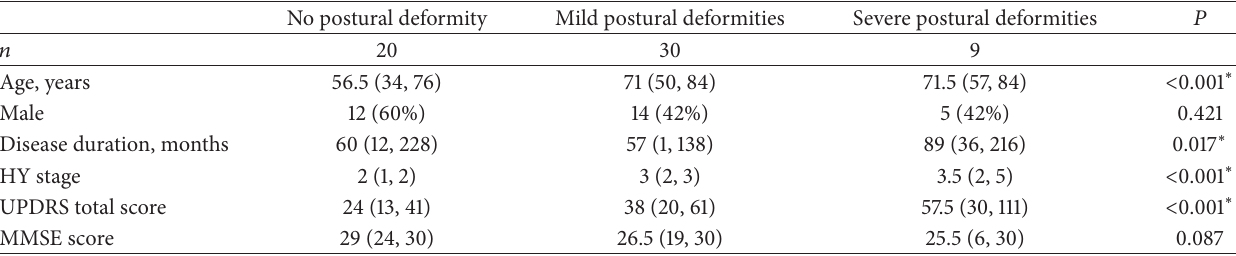
Table 1: Demographics and disease characteristics of the